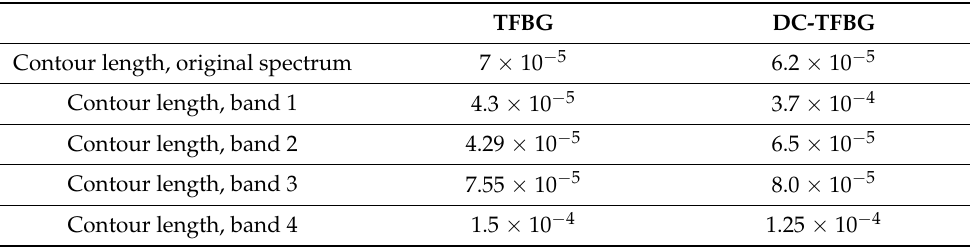
Table 1. Comparison of the resolution for the TFBG and DC-TFBG for optical spectra for individual frequency ranges.